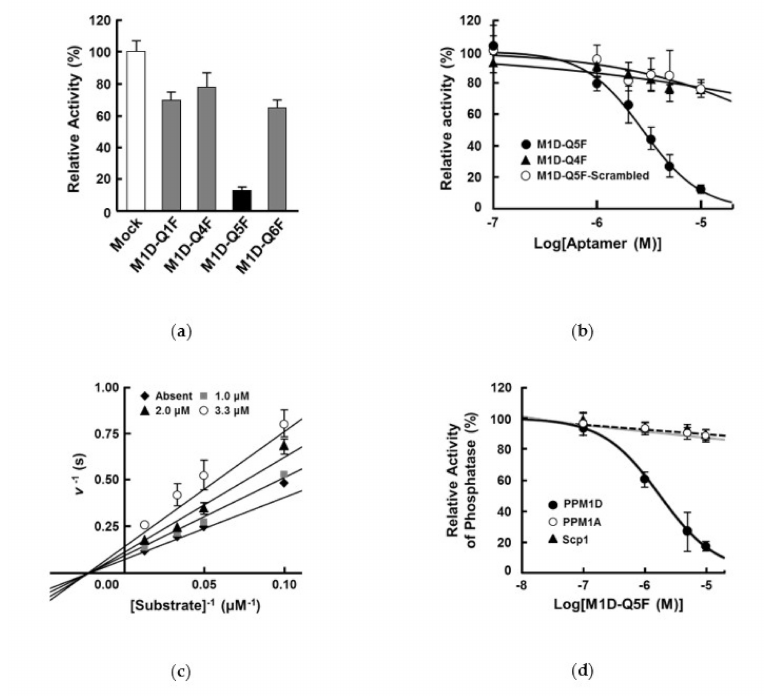
Figure 2. Inhibitory activity of identified IRDAptamer against PPM1D. ( a ) The inhibitory activity of identified aptamers at 10 µ M. In vitro phosphatase analyses were performed with 4 nM recombinant His-PPM1D430 using 10 µ M p53(15pS) peptide as substrate. Data represent the mean ± S.D. (n = 6). ( b ) Dose-dependency of aptamers against PPM1D430 (filled circle, M1D-Q5F; triangle, M1D-Q4F; opened circle, M1D-Q5F-Scrambled). Data represent the mean ± S.D. (n = 6). ( c ) Analysis of inhibition mode of M1D-Q5F aptamer. Lineweaver–Burk plot showed non-competitive inhibition (diamond, absent; square, 1.0 µ M; triangle, 2.0 µ M; circle, 3.3 µ M). Data represent the mean ± S.D. (n = 6). ( d ) Specificity of M1D-Q5F aptamer. Phosphatase analyses were performed with 20 nM recombinant His-PPM1D430 (filled circle), His-PPM1A (opened circle), His-Scp1 (triangle) using 1 mM p NPP as substrate. Data represent the mean ± S.D. (n =